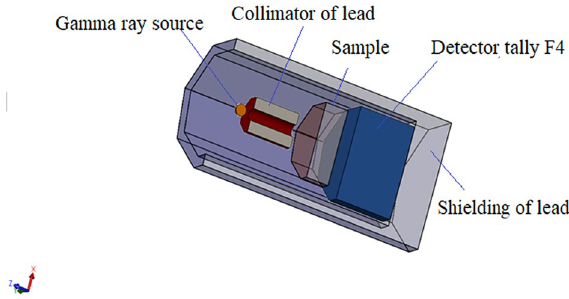
Figure 1. Schematic geometrical set-up for MCNP simulations.